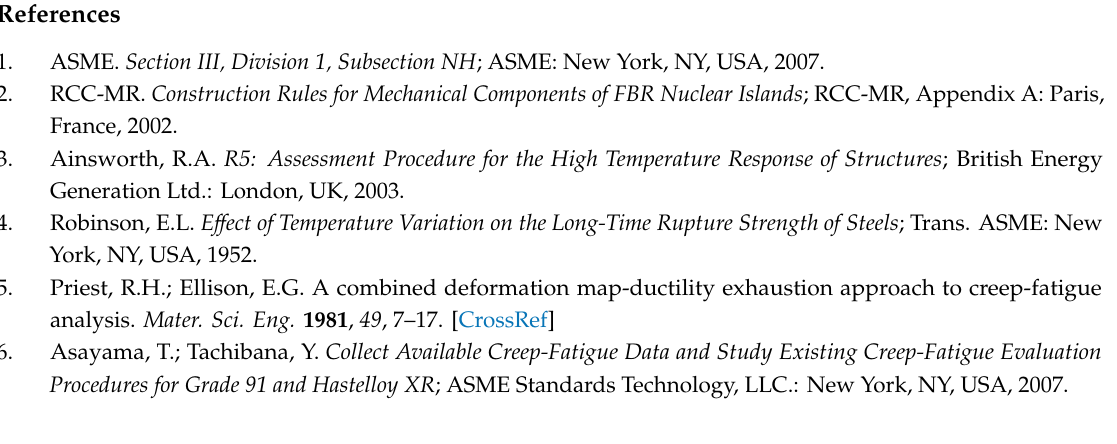
Figure 11. Creep damage per cycle versus creep-fatigue life.